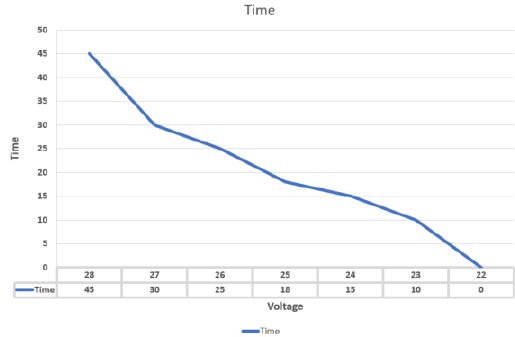
Fig.2: Time to Voltage